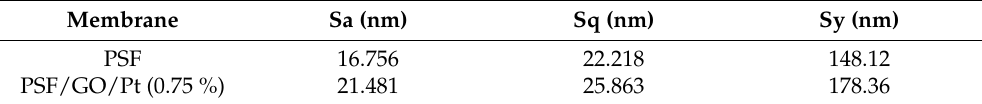
Figure 4. Two-dimensional and three-dimensional AFM images of membranes: ( a ) PSF and ( b ) PSF-GO/Pt (0.75 wt%) nanoparticles. Table 1. AFM parameters and water contact angles of PSF and PSF-GO/Pt (0.75 wt%) membranes.